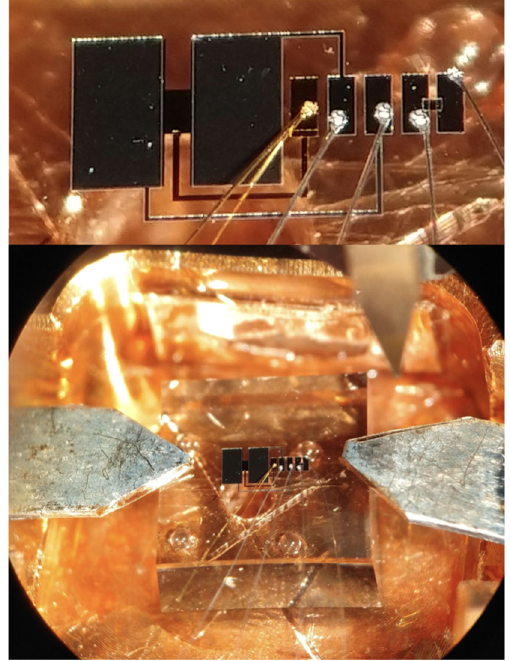
Fig. 1 Top: Picture of the TES sensor fabricated on one of the two diamond crystals. On the left, it is possible to see two large aluminum areas (0.5 × 1) mm 2 evaporated on top of a darker strip of tungsten (140 × 300) µ m 2 .A50nmthickand1.5mmlongstripofgoldconnects the tungsten layer to a 40 µ m thick gold pad, to which we bond a 25 µ m gold wire; this gold wire provides a weak thermal coupling to the heat bath at ∼ 10 mK. On the right part of the picture, there is the heater: this ismadeofa50nmthickstripofgoldwithtwoaluminumpadsdeposited on top. Bottom: One of the two diamond crystals instrumented with the